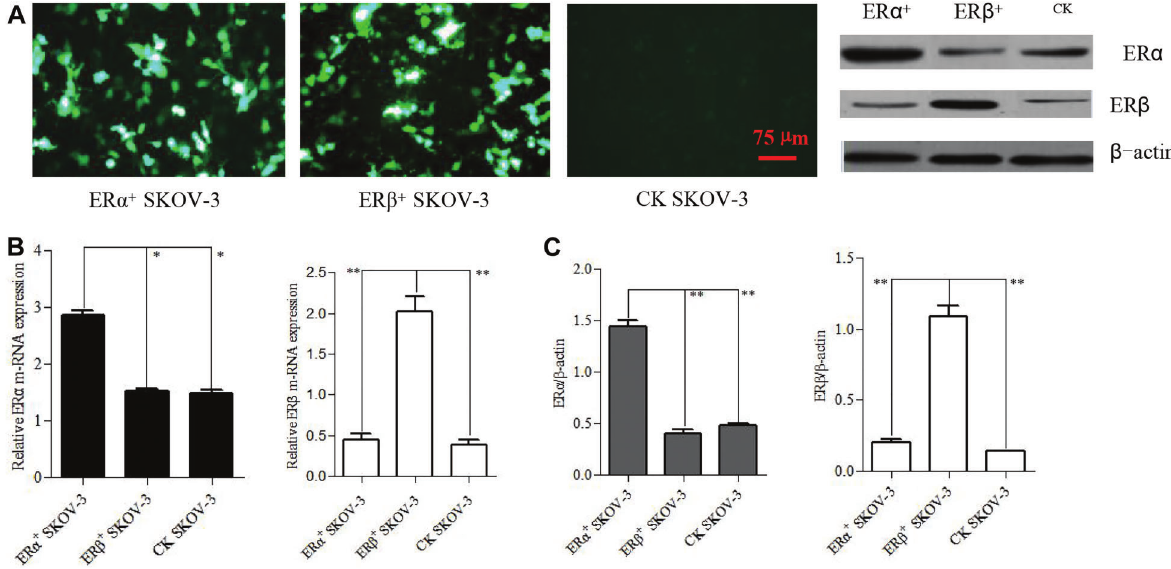
Figure 3. Over-expression of estrogen receptors (ERs) in SKOV-3 human ovarian cancer cells. The 293T pLV-ER a or 293T pLV-ER b vector co-transfected with SKOV-3 cells was used to generate ER a + and ER b + SKOV-3 cell lines, respectively. CK SKOV-3 cells referred to blank plasmid transfection. A , transfection ef fi ciency validated by inverted fl uorescence microscope. Green fl uorescence indicates that cells were successfully transfected. B , ERs m-RNA expression levels by RT-PCR. C , ERs protein expression levels by western blotting. b -actin was used as the internal standard. Data are reported as means ± SD (*P o 0.05, **P o 0.01,